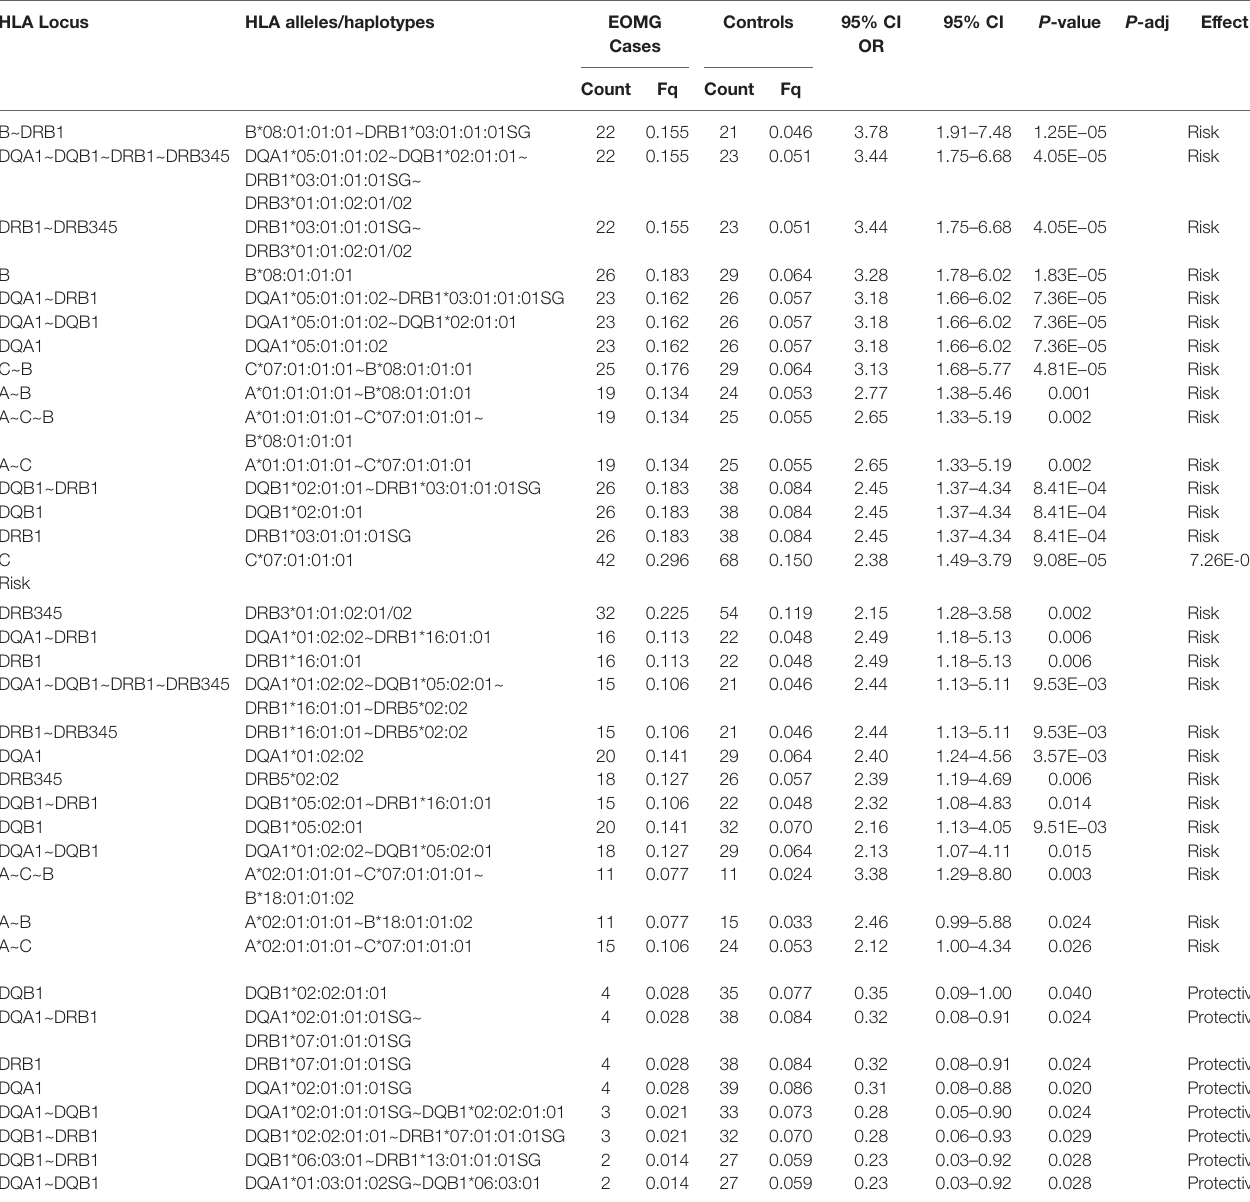
TABLE 2 | Signi fi cant associations of HLA alleles and haplotypes in Italian EOMG AChR-antibody positive cases and controls ranked by odds ratios. HLA Locus HLA alleles/haplotypes EOMG